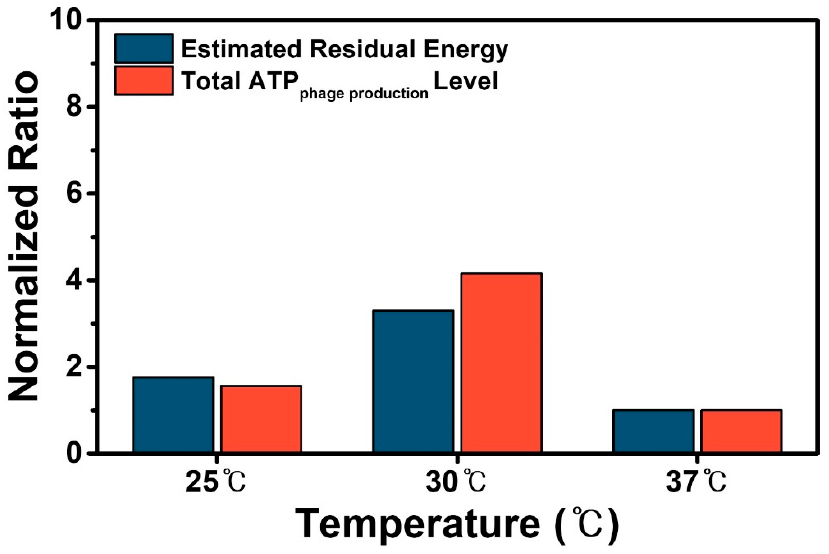
Figure 4. Normalized comparison between model-based estimated residual energy and experimen- tally calculated ATP expenditure for M13 phage production. Data of each culture temperature was normalized with the data at 37 ◦ C to compare the similarity of the estimated residual energy and experimentally calculated ATP expenditure for phage production in the same bulk scale. Total ATP expenditure level for phage production was calculated by multiplying the ATP percentage for phage production with E. coli cell number per mL at each temperature followed by normalization. In a bulk dimension, the normalized ratio of the two data sets at 25 ◦ C produced 89.1% similarity while data at 30 ◦ C showed 79.3% similarity. Table 2. Optimal conditions of ATPase with Walker A and Walker B structure from bacterial